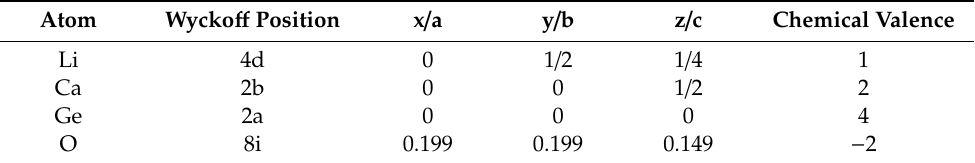
The Li 2 CaGeO 4 crystal structure consists of [LiO 4 ] and [GeO 4 ] tetrahedra and a [CaO 6 ] octahedron [25]. In the structure of Li 2 CaGeO 4 , Ca is in a dodecahedral position, Ge has four types of tetrahedra, and the other tetrahedron is occupied by Li [26]. According to the work reported by Shannon [27], we know the connection between the coordination number and the ionic radius, so we can determine the ionic + + radii of cations with Li ions (CN = 4, ion radius = 0.59 Å), Ca 2 ions (CN = 8, ion radius = 1.12 Å), Table 1. The structural parameters of Li 2 CaGeO 4 derived from X-ray diffraction data. + + + Ge 4 ions (CN = 4, ion radius = 0.39 Å), and Cr 4 ions (CN = 4, ion radius = 0.41 Å). As the Cr 4 ionic + + + radius is similar to that of Ge 4 , Cr 4 ions can replace the cation site Ge 4 in the tetrahedron symmetry. Atom Wyckoff Position Table 1. The structural parameters of Li 2 CaGeO 4 derived from X-ray di ff raction data. Atom Wycko ff Position x / a y / b z / c Chemical Valence